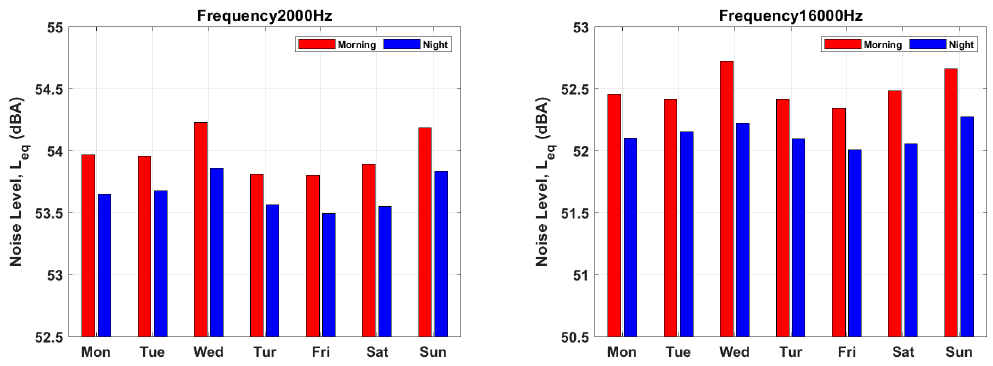
Figure 10. Average morning vs. night at 125 Hz and 1000 Hz in a week for all sensors.